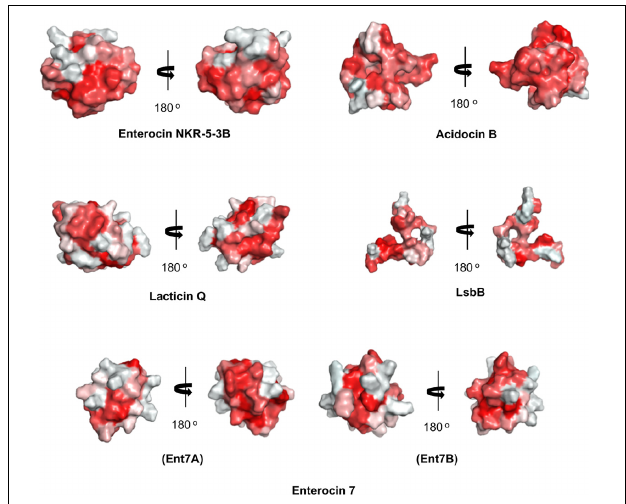
FIGURE 7 | Hydrophobic surface maps of representative sub-groups of circular and leaderless bacteriocins. Enterocin NKR-5-3B and acidocin B represent group i and group ii circular bacteriocins, respectively. Lacticin Q and LsbB represent saposin fold exhibiting and single helical structure exhibiting single peptide leaderless bacteriocins, respectively. Enterocin 7 (Ent 7A and Ent 7B) represents the saposin fold exhibiting two-peptide leaderless bacteriocins. Red indicates hydrophobic residues and white represents hydrophilic resides. The color intensity indicates the hydrophobicity or hydrophilicity of the residues. Images are generated using PyMol Molecular Graphics